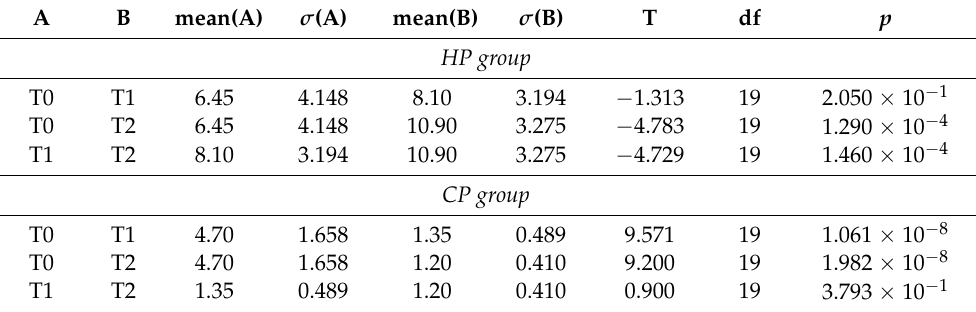
Table 2. Pairwise t-tests performed for both the hydrogen peroxide (HP; n = 20) and carbamide peroxide (CP; n = 20) groups of treatments. A and B represent different treatment times (T0, T1, and T2), σ is the variance, and df is the degrees of freedom ( n − 1).